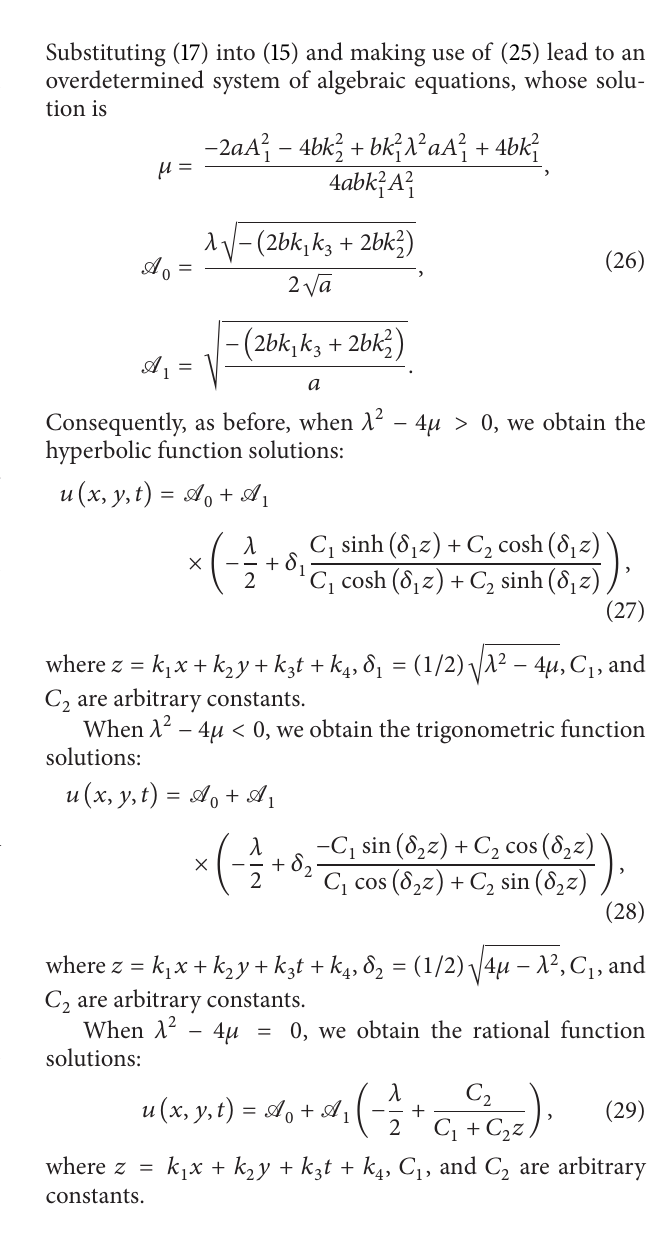
Figure 2: Profile of solution (22). Figure 3: Profile of solution